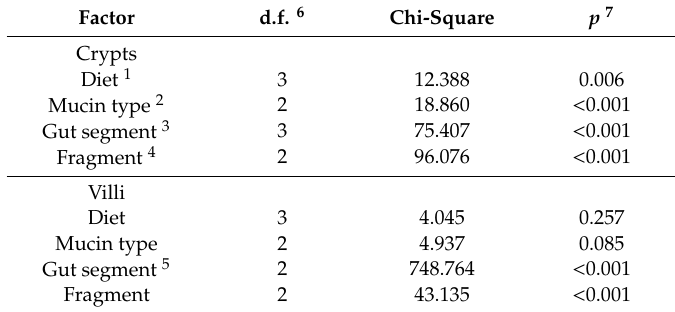
Table 1. Influence of the considered predictor factors (diet, mucin type, gut segment and crypt-villus fragment) on the gut mucin staining intensity in the heavy-size broiler chickens.